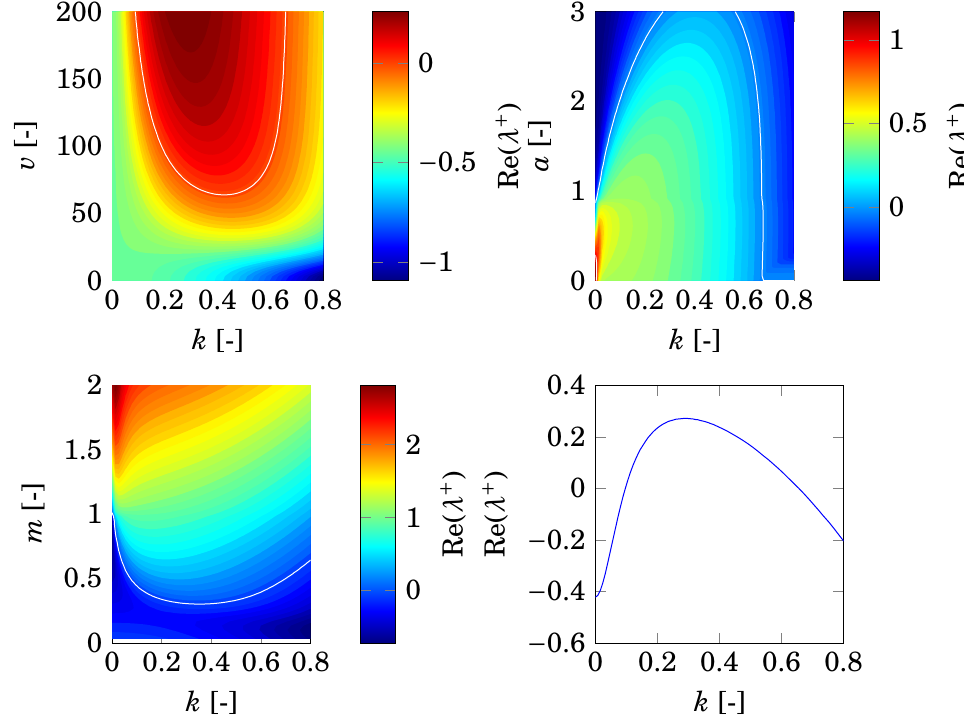
Figure 2. The dependence of the differential flow-induced instability on the wavenumber k , precipitation parameter a , slope v and mortality rate m is shown. Other parameters are given by the reference parameters for grass ( a = 2, m = 0.45, and v = 182.5). The region of instability is restricted by the white line. The figure at the bottom right shows separately the dependence of the differential flow instability on the wavenumber for the reference